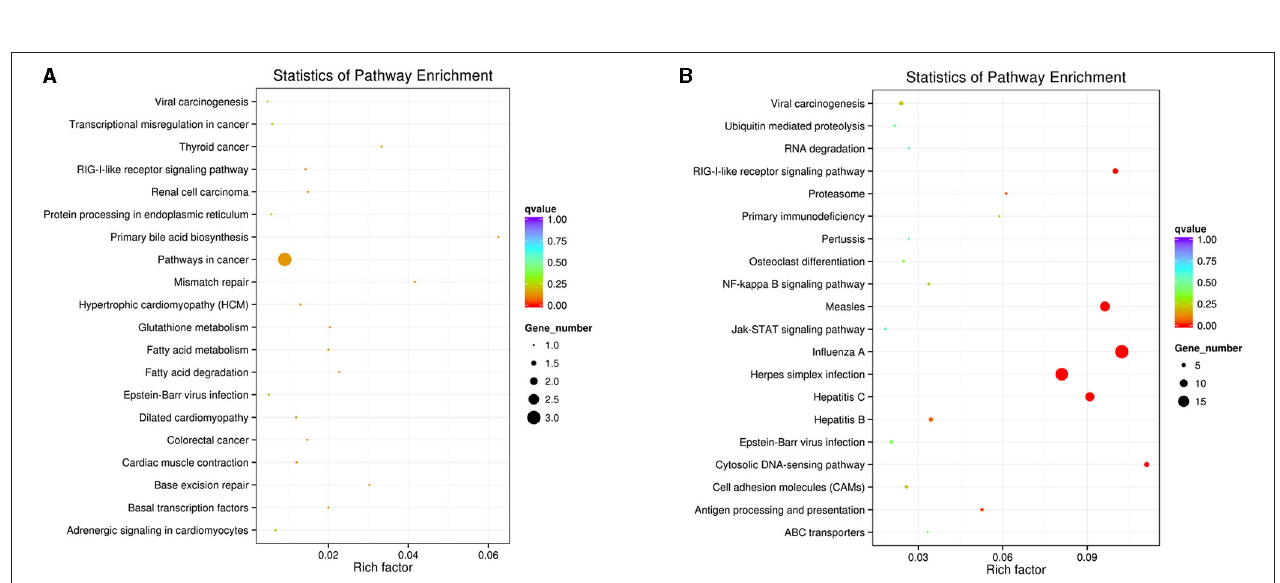
FIGURE 2 | Gene Ontology (GO) enrichment analysis of DEGs in the IFNT-treated gEECs. GO terms with adj. p -value < 0.05 were considered significantly enriched by DEGs. BP, biological process; MF, molecular function.